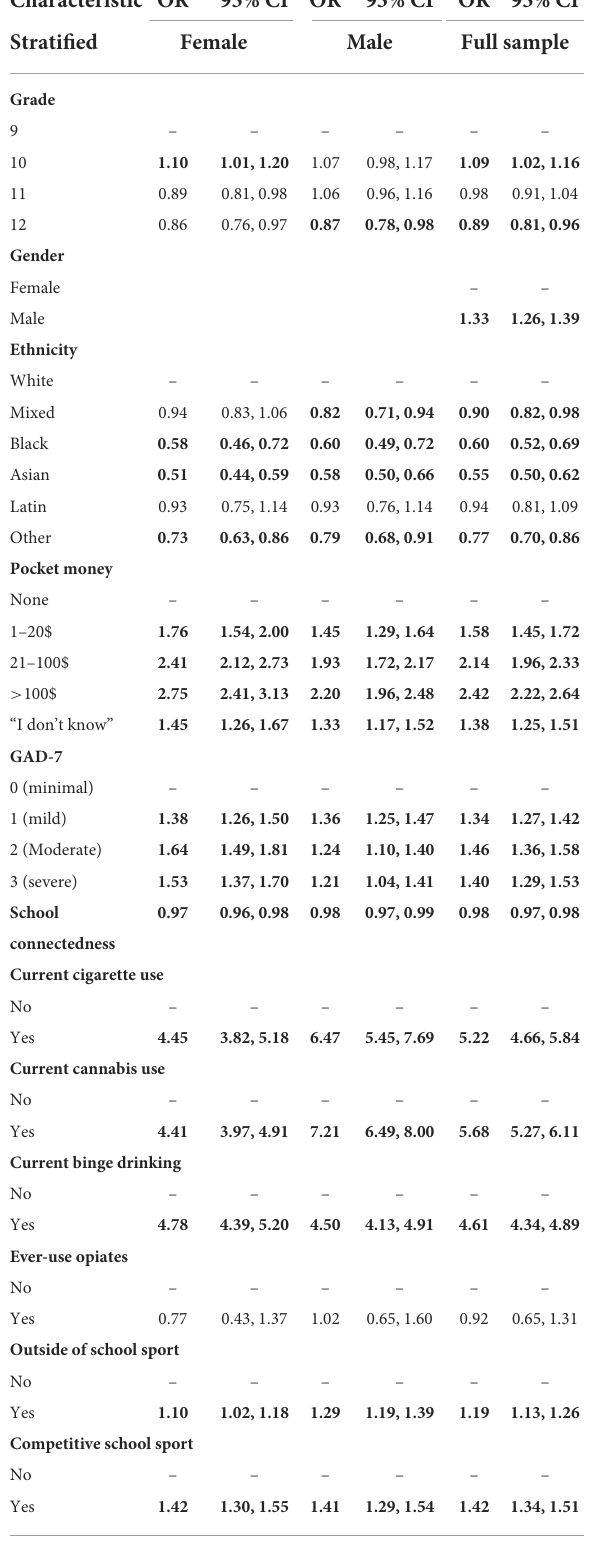
TABLE 3 Full model summaries for current e-cigarette use.